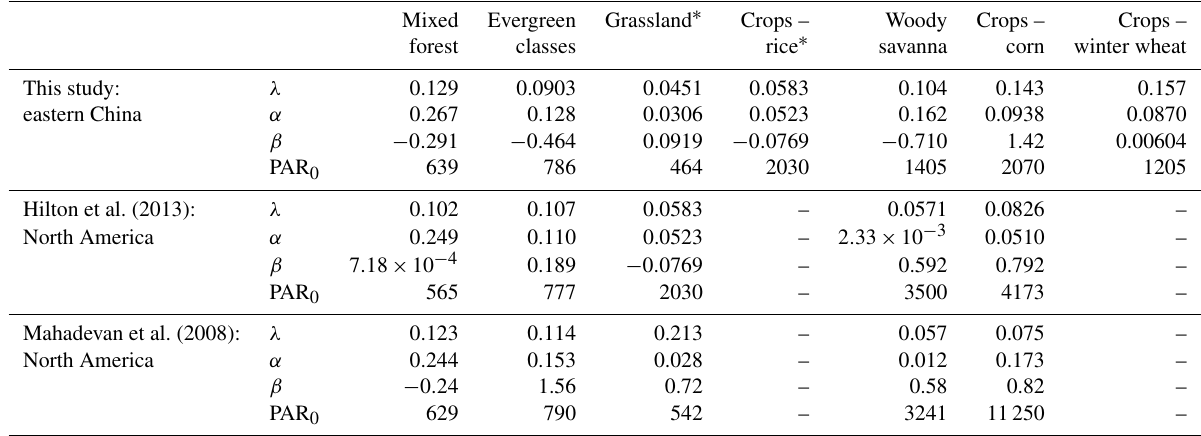
Table 2. VPRM-CHINA scaling parameters by IGBP class compared to previous studies. Units are as follows: λ : µmolCO 2 m − 2 s − 1